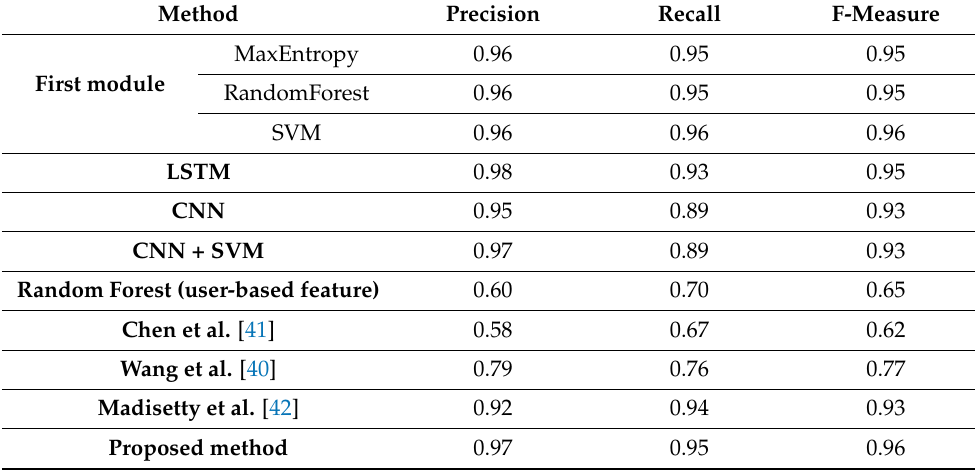
Table 6. Evaluation Results for Dataset